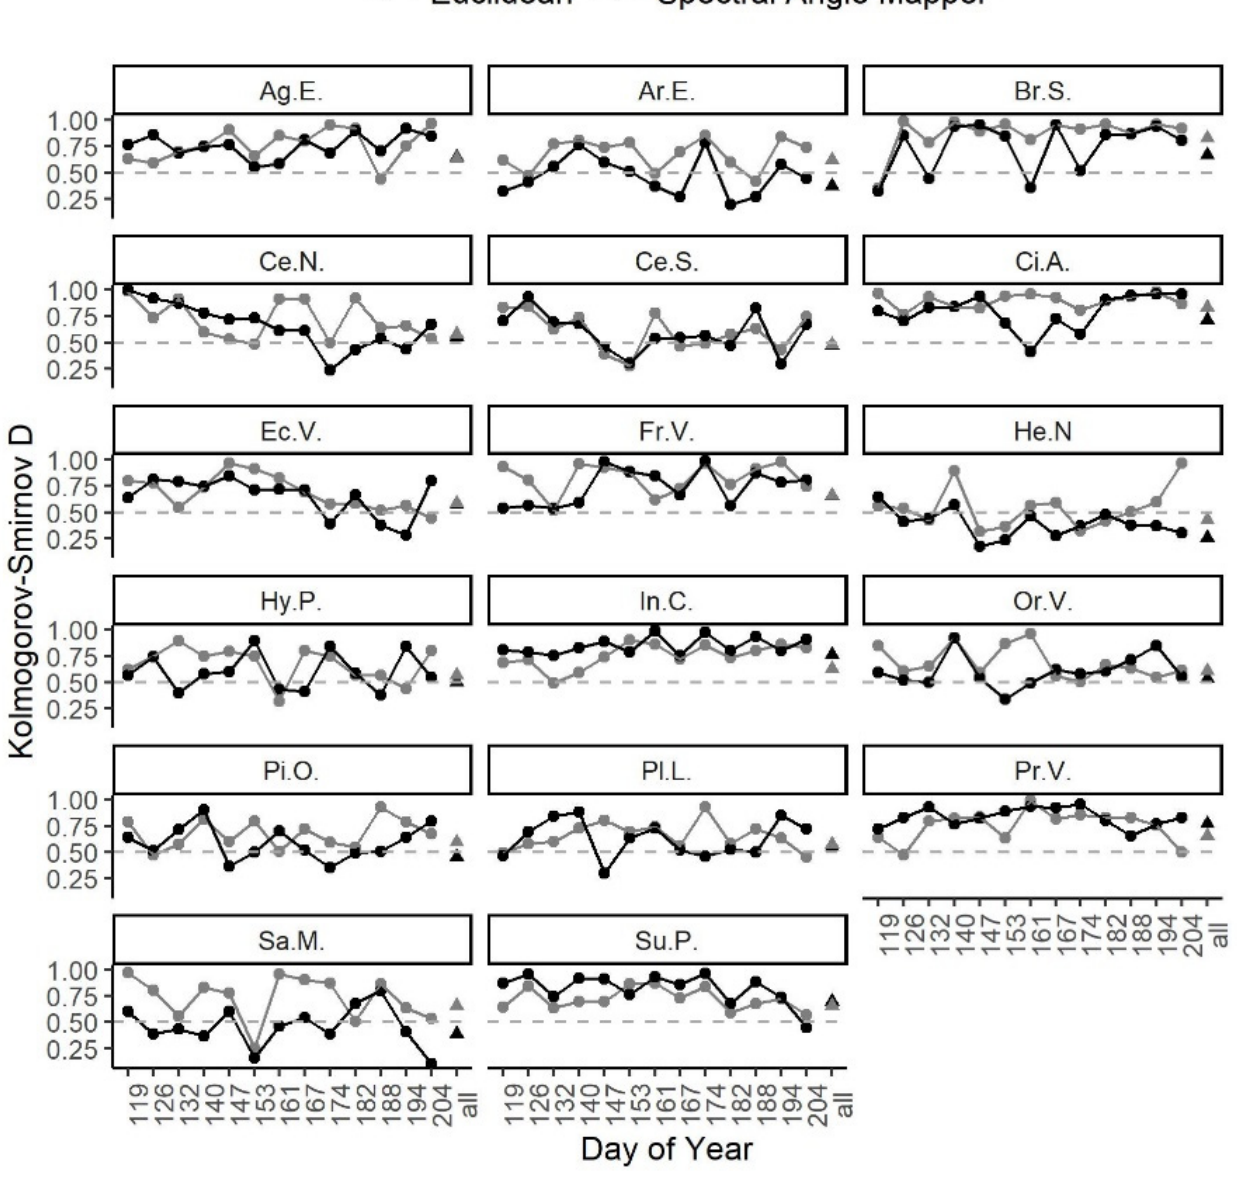
Figure 3. The value of D (the Kolmogorov–Smirnov statistic): a test of whether the distributions of the intra-specific and inter-specific distances were different from each other at each time point and across all sampling dates for each species class. The results are shown for both the Spectral Angle Mapper and the Euclidean distance. The values of D ranged from 1–0, with higher values representing distributions that were more distinct. A p value = 0.01 for the test is shown by a dashed line. Values above the line denote significantly different distributions.